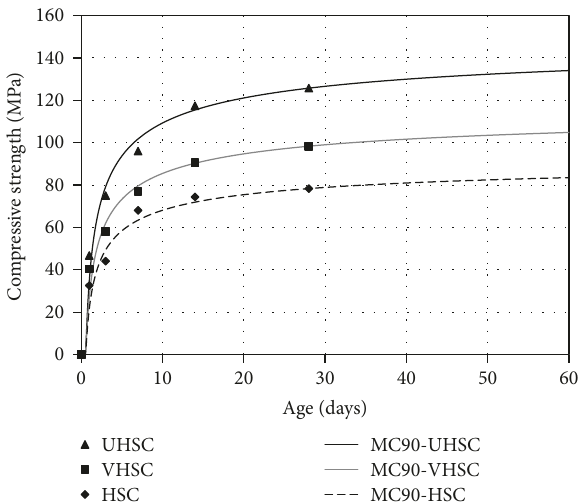
Figure 4: Comparison of compressive strengths of test results and CEB-FIP MC90